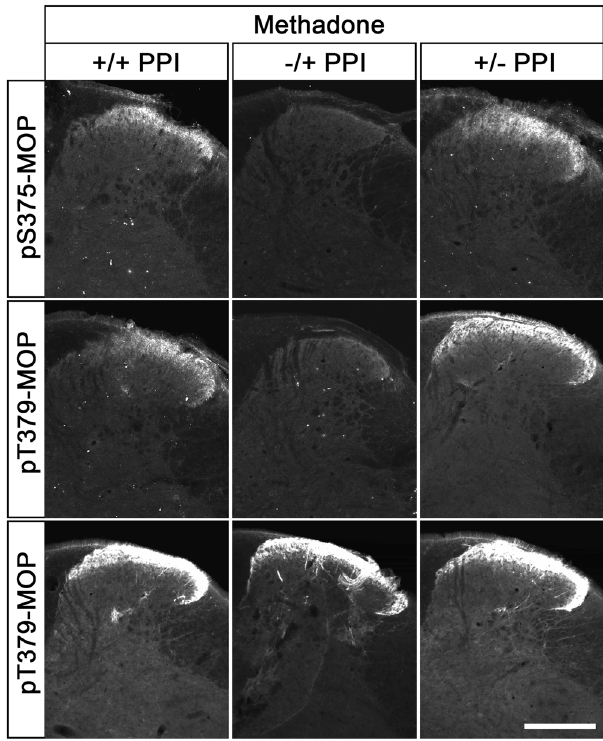
Fig. 5 Comparison of phospho-MOP detection after staining in the presence or absence of PPIs. Animals were treated with methadone for 30 min, transcardially perfused and fi xed in the presence ( + ) or absence (-) of PPIs and also stained in the presence ( + ) or absence (-) of PPIs. Shown are confocal images of coronal sections of the spinal cord stained with pS375-MOP, pT379-MOP or np-MOP antibody. Note that PPIs need to be present during the whole fi xation procedures but not during the staining protocol to obtain agonist-induced phospho-MOP immunostaining. Scale bar = 250 µ